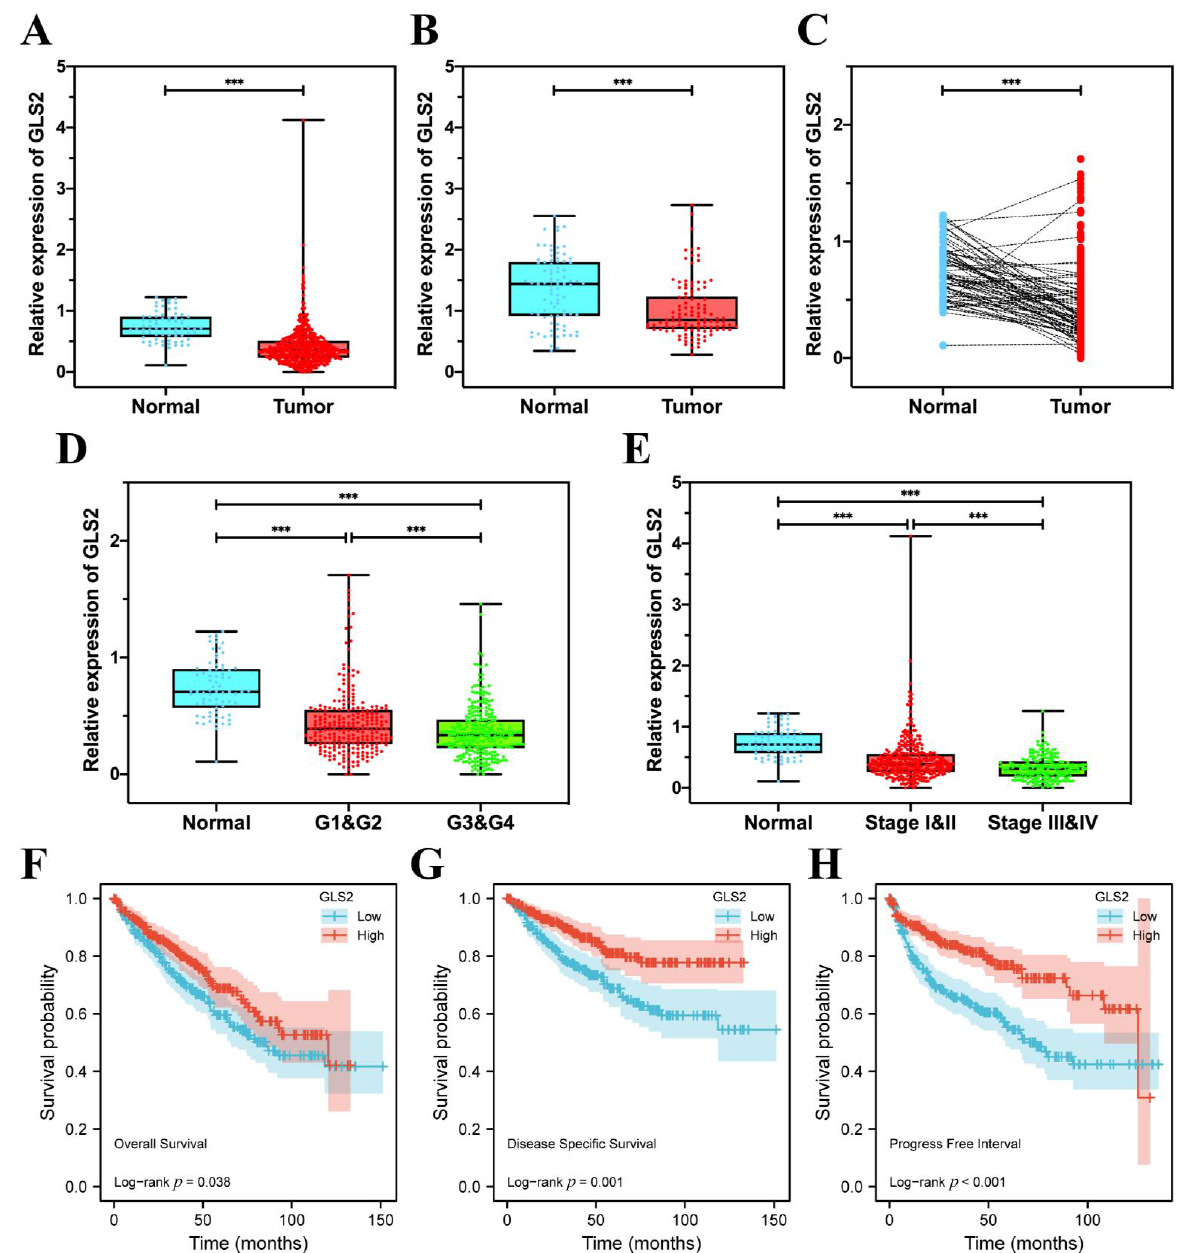
Figure 8. GLS2 was downregulated in ccRCC tissue and closely correlated with prognosis. ( A ) The mRNA expression of GLS2 between normal kidney tissues and ccRCC tissues in TCGA. ( B ) The proteomic expression of GLS2 between normal kidney tissues and ccRCC tissues in CPTAC. ( C ) The mRNA expression of GLS2 between ccRCC tissues and paracancerous tissues in TCGA. ( D ) The mRNA expression of GLS2 in normal kidney tissues and different grade groups in TCGA. ( E ) The mRNA expression of GLS2 in normal kidney tissues and different stage groups in TCGA. ( F ) The OS of ccRCC patients in groups of high or low GLS2 expression. ( G ) The disease specific survival of ccRCC patients in groups of high or low GLS2 expression. ( H ) The progress-free interval of ccRCC patients in groups of high or low GLS2 expression. (*** p < 0.001). 3.8. GLS2 Might Be a Suppressor of Ferroptosis in ccRCC